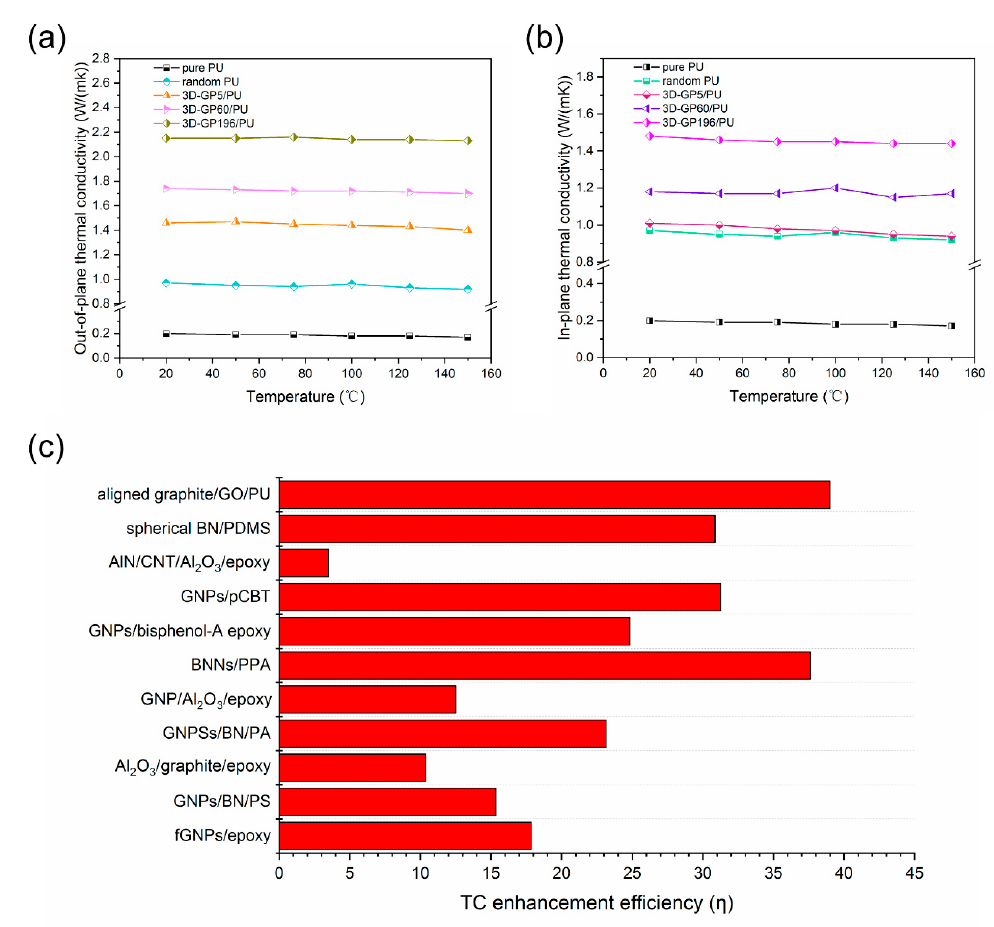
Figure 6. ( a ) Out-of-plane and ( b ) in-plane thermal conductivity with temperature. ( c ) Comparison of thermal conductivity (TC) enhancement efficiency of reported composites.